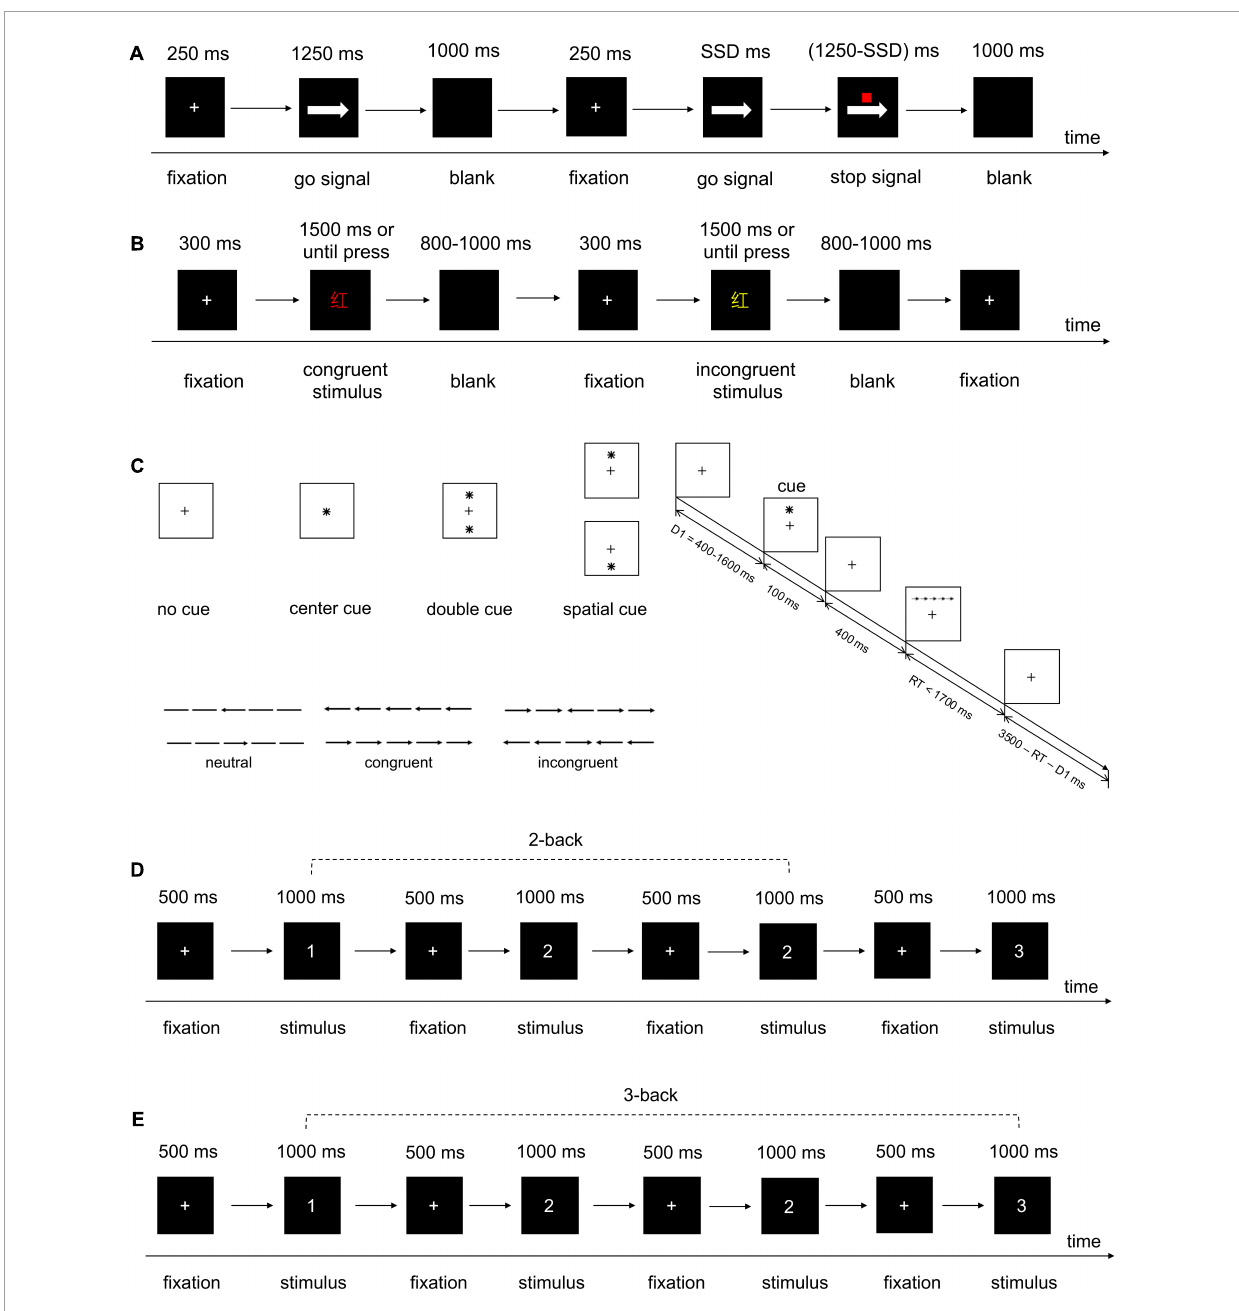
FIGURE3 Detailed information about procedures of behavioral tasks. (A) SST. (B) Color-word Stroop task. (C) ANT. (D) 2-back task. (E) 3-back